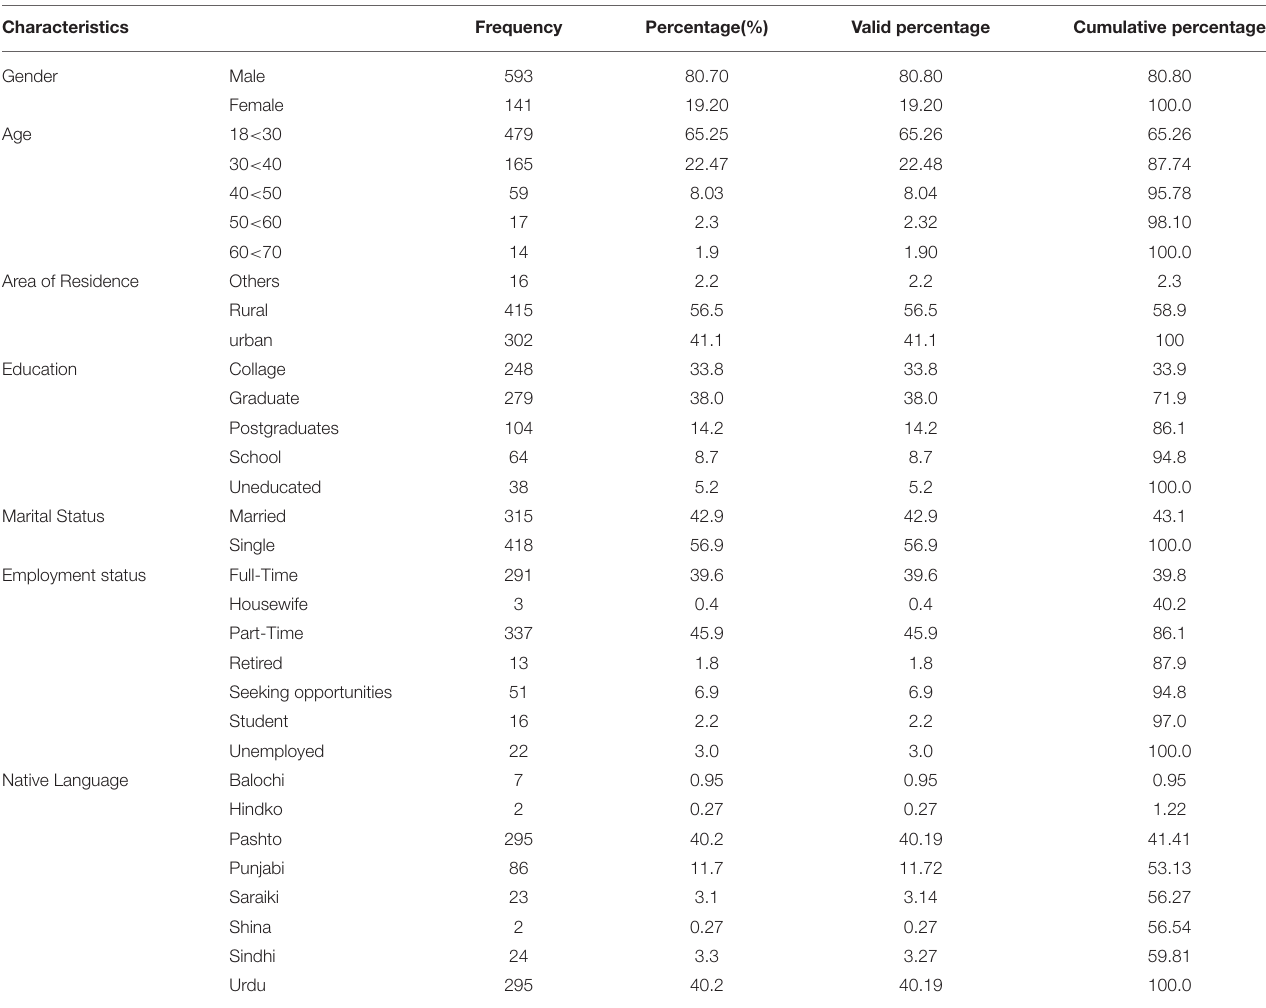
TABLE 1 | Demographic characteristics of participants ( N = 734).